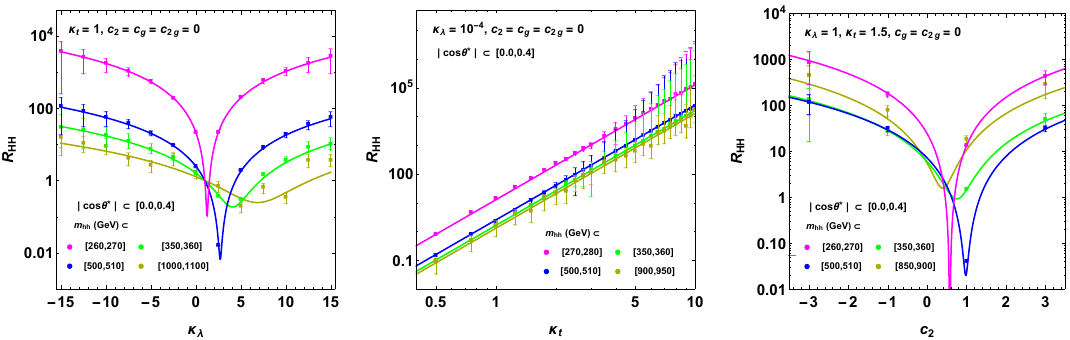
Figure 13 . Comparison of R j , obtained from the analytical formula (2.4), with the same ratio, hh as derived directly via MC, for the most central bin in cos θ ∗ (betweem 0 and 0.4) and for four different bins in m hh , capturing threshold, interference, and high energy regions. From left to right we show a scan in κ λ , κ t and c 2 , respectively, while keeping the other parameters at fixed values. The error bars have a pure statistical source related with the generated number of events.